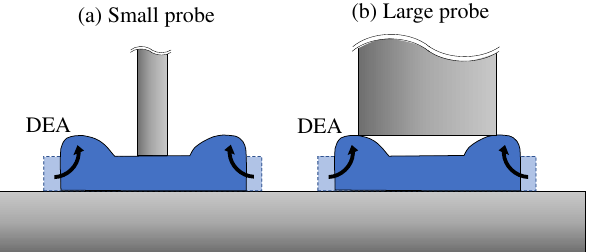
Figure 1. Schematic showing difficulty of surface contact between a probe and a locally deformed thin stacked dielectric elastomer actuator (DEA). The appropriate contact cannot be achieved both ( a ) when a small probe is used and ( b ) when a large probe is used.